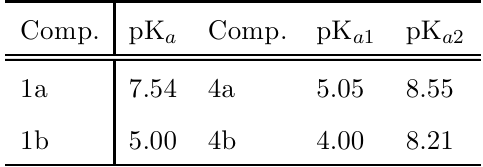
Table 5 The pK a values of compounds 4a,b and